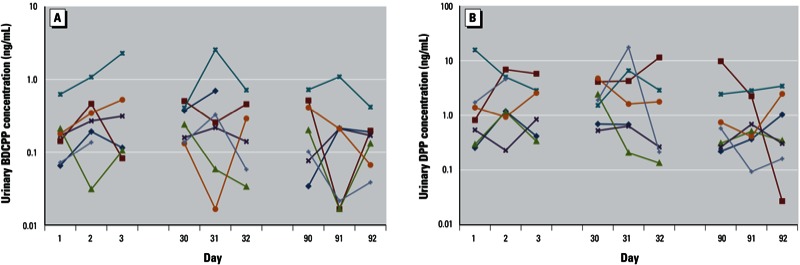
Concentrations (ng/mL) in urine from repeated samples collected from seven men over a 3-month period. (A) BDCPP; (B) DPP. Colors represent individual men.